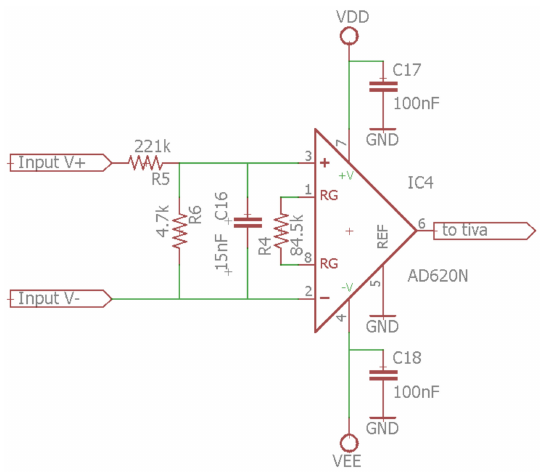
Figure 6. Attenuation stage for the voltage measurement.